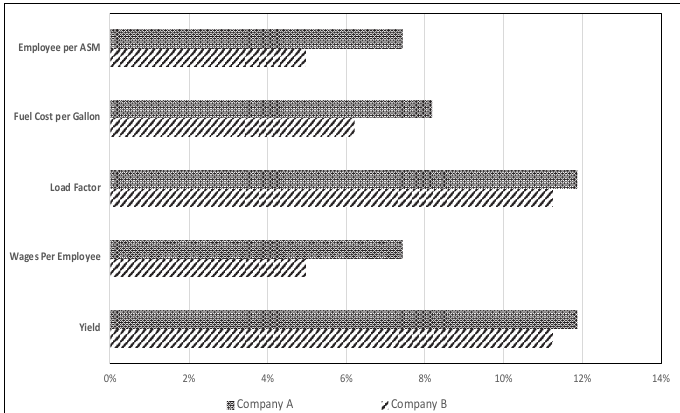
Fig. 2. Simulation Result of ROIC improvement as a function of 10% change in detailed operational variables